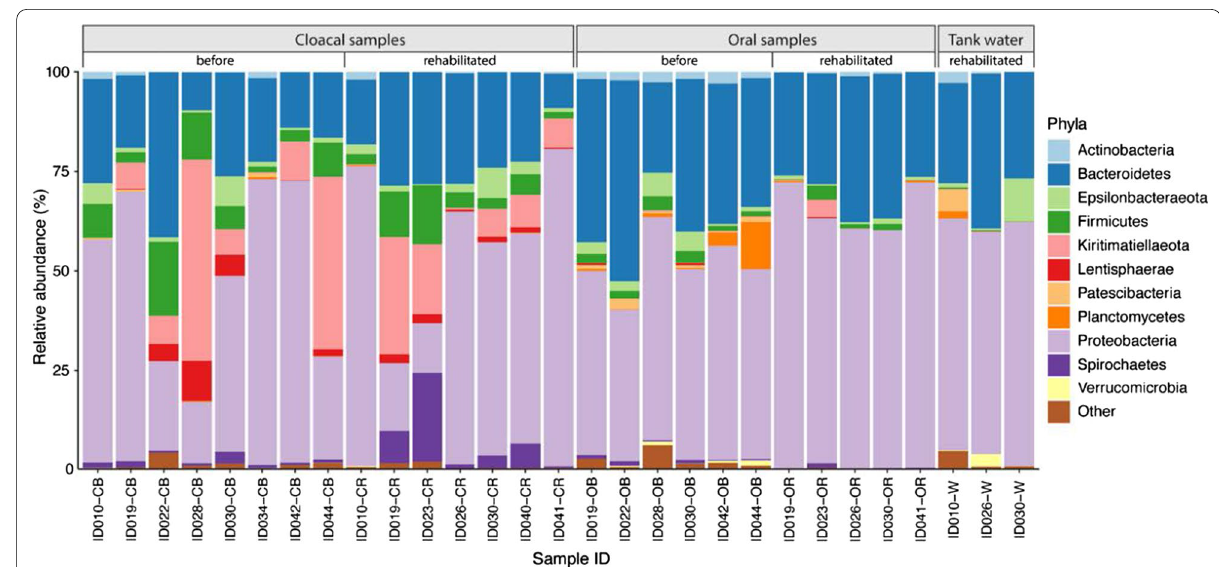
Fig. 5 Relative abundances (%) of bacterial phyla present (> 1% on average per sampling site) in loggerhead cloacal, oral and tank water samples. Turtle ID suffix indicates the sampling site and period (before or during/after rehabilitation) as follows: CB, cloacal before; CR, cloacal rehabilitated; OB, oral before; OR, oral rehabilitated; W, tank water